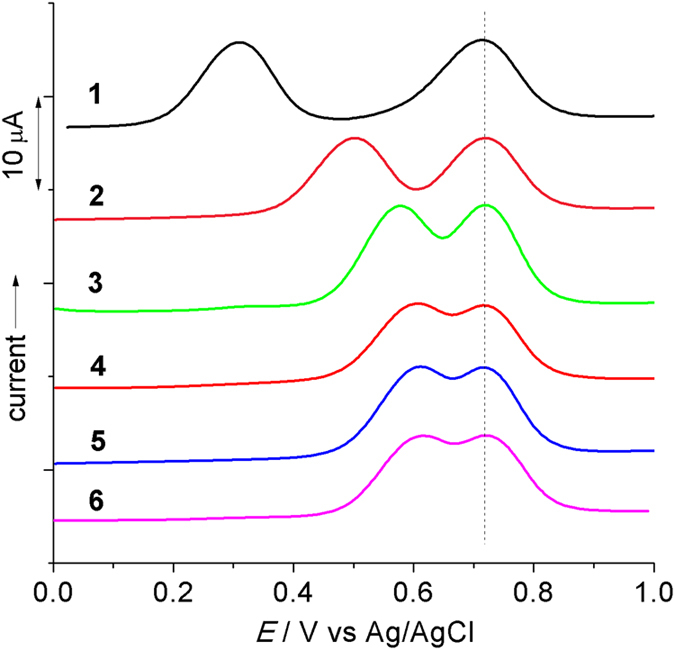
Anodic DPVs of 1(PF6)–6(PF6) in 0.1 M Bu4NClO4/CH2Cl2.E1/2 = +0.310 and +0.720 V for 1, +0.500 and +0.720 V for 2, +0.574 and +0.717 V for 3, +0.606 and +0.718 V for 4, +0.611 and +0.718 V for 5, and +0.616 and +0.721 V for 6, respectively. The potential splitting is 410, 220, 143, 112, 107, and 105 mV for 1–6, respectively.